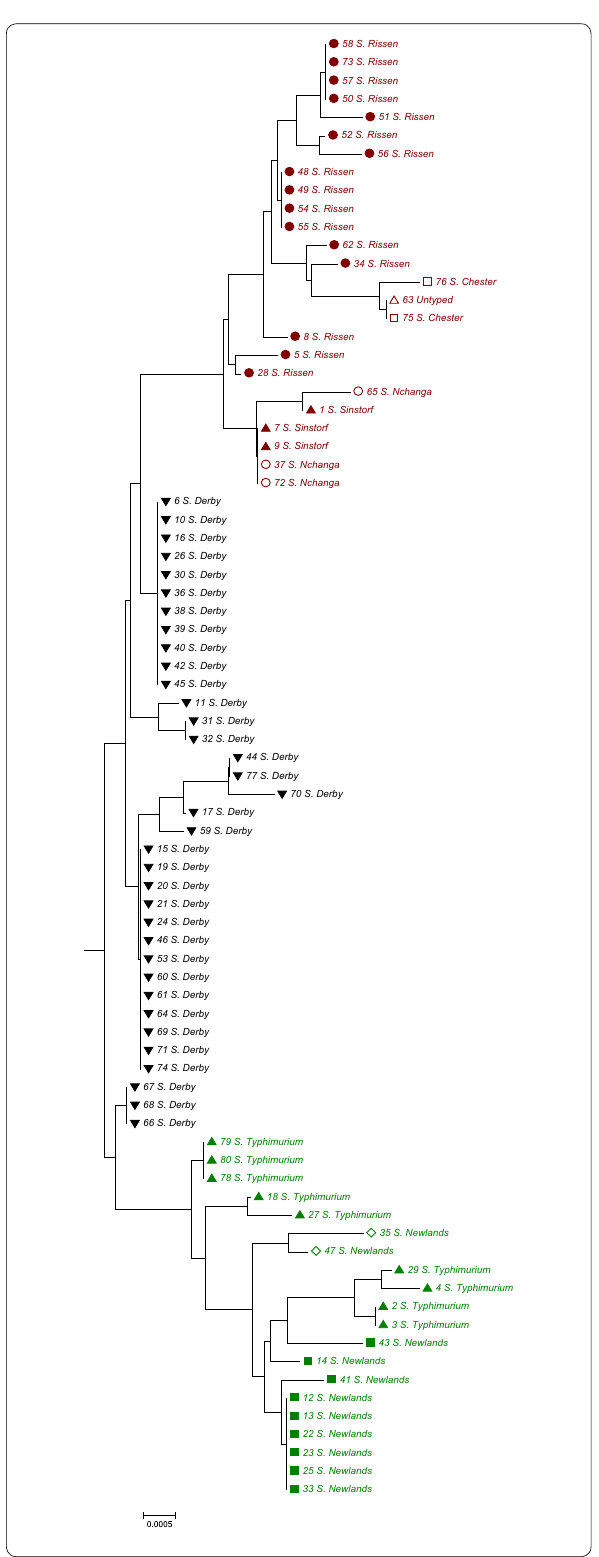
Fig. 1 Phylogenetic tree of 80 Salmonella isolates based on 16S rRNA analysis. 16S rRNA gene sequences (1466 bp) were amplified by PCR and the nucleotide sequences determined. This is a neighbour-joining tree based on 80 Salmonella 16S rRNA sequences. The scale bar indicates one base substitution per 10,000 nt position. The number shown next to each node indicates the bootstrap value (1000